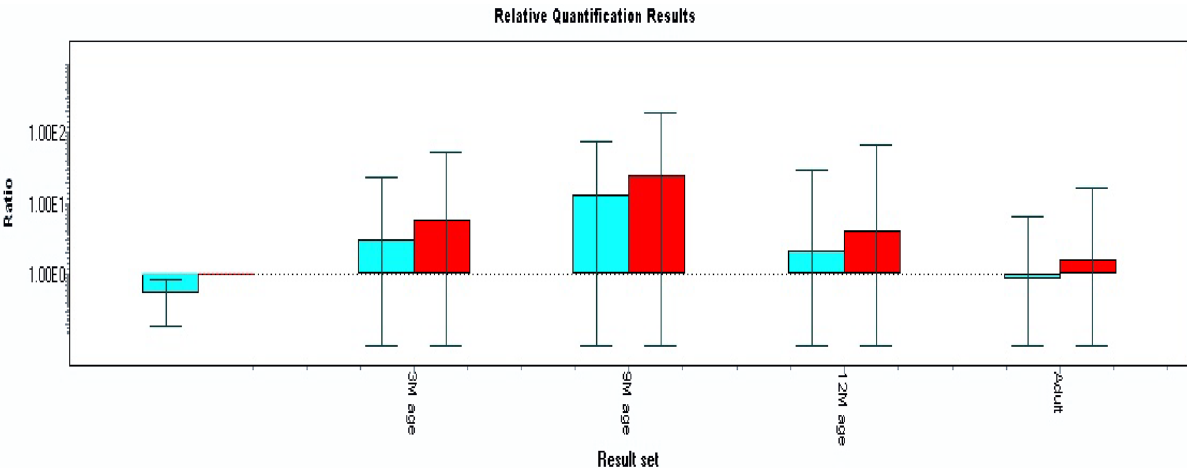
Figure 1. Relative mRNA expression (fold change) of HSP70 gene in different age groups of Jamunapari goat. 3 M, 3-month age of animal; 9 M, 9-month age of animal; 12 M, 12-month age of animal; adult, 2–3 year age of animals. The crossing point (Cp) readings for each unknown sample were then used to calculate the amount of either the target or housekeeping gene using the second derivative maximum method with the Light cycler 480 analysis software version 1.5 (Roche Applied Science, Indianapolis, IL, USA). GADPH and β-actin were used to normalize gene expression. The susceptible individual was used as a positive calibrator to obtain normalized gene